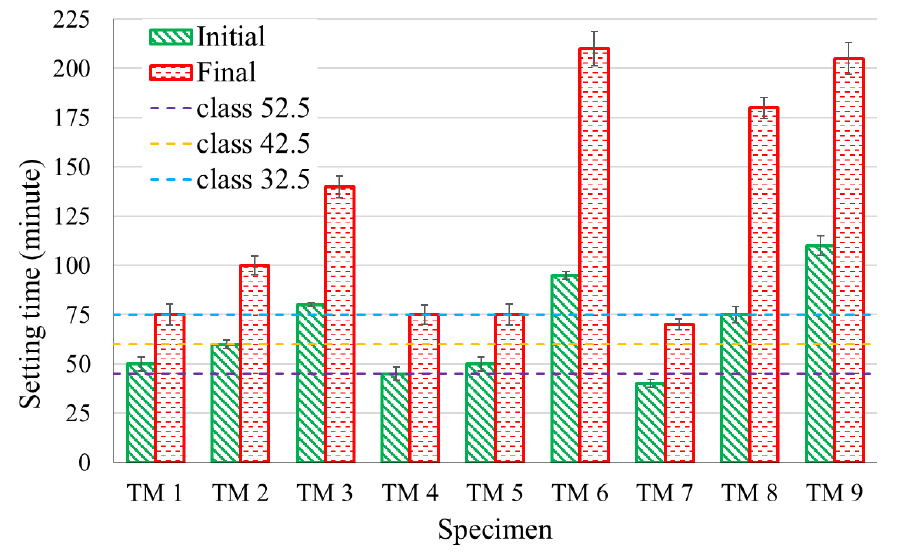
Figure 1. Initial and final setting times according to Vicat setting time test.